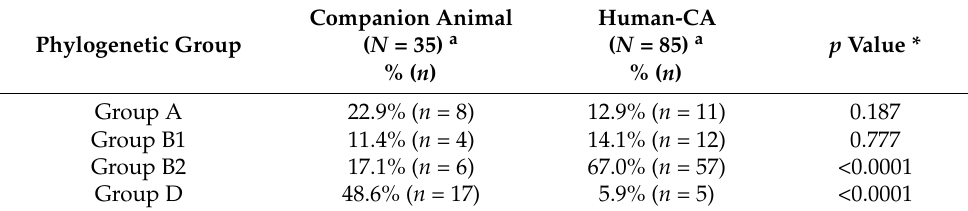
Table 2. Phylogenetic groups of 3GC-resistant E. coli isolated from companion animals and humans with